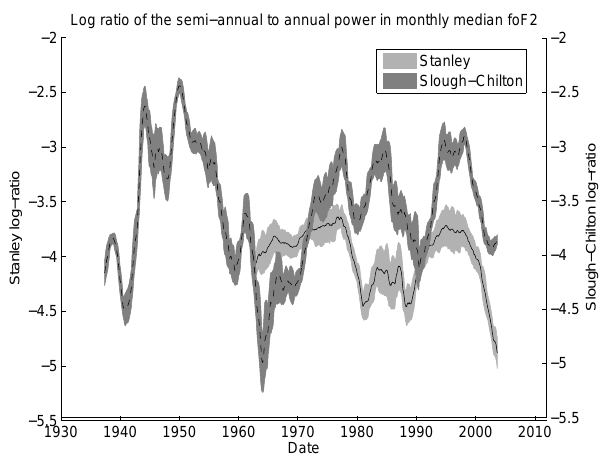
Fig. 5. Time series of the log ratio of semi-annual/annual values seen at Slough/Chilton (dashed line with dark grey error band) and Stanley (solid line with light grey error band) at local midnight. The grey error bands represent the error in the mean over the frequency band used to produce each line. Note the change in scale compared with Fig. 4.